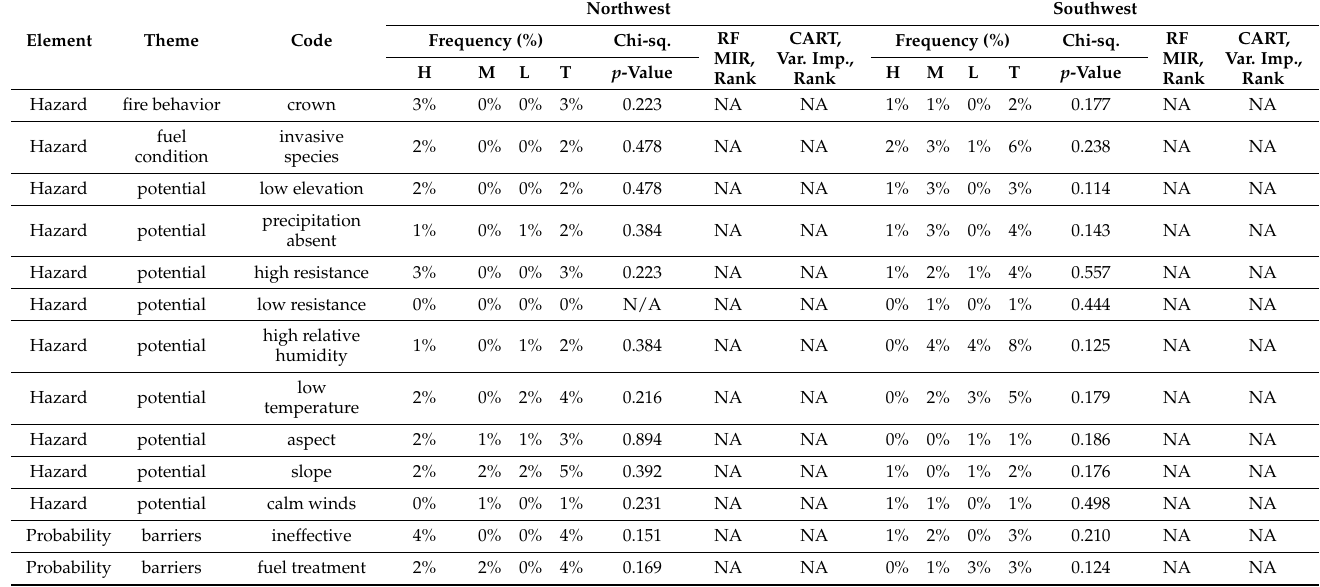
Table A1. Codes that occurred with low frequency, are not significant (chi-square > 0.05) and are not ranked in either the Random Forest or CART